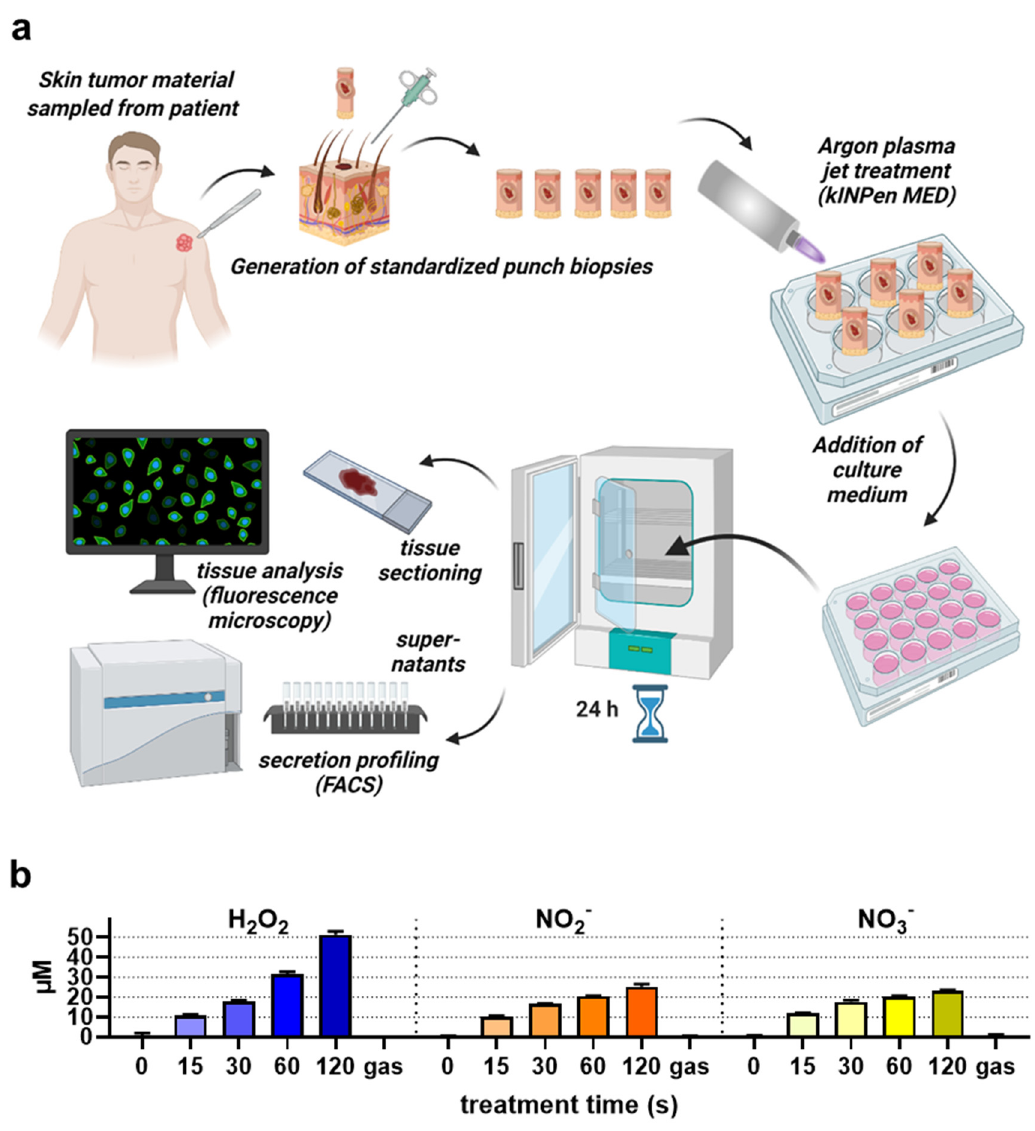
Figure 2. Human tumor tissue sampling and treatment scheme: ( a ) excised skin tumors were retrieved and used to generate punch biopsies of identical sizes. The punch biopsies were subsequently added to microtiter well plates for standardized gas plasma treatment. Afterward, cell culture medium was added to each well and the samples were incubated for 24 h, before supernatants were collected and tissues were cryo-sectioned and stained. Supernatants were analyzed using multiplex flow cytometry, and cryo-sections were stained with antibodies, followed by quantitative immunofluorescence imaging; ( b ) quantification of ROS (hydrogen peroxide, H 2 O 2 ) and RNS (nitrite, NO 2 − ; nitrate, NO 3 − ) in plasma-treated liquids (200 µL of PBS). Gas refers to 120 s of exposure of the liquid with argon gas only (i.e., plasma = off).